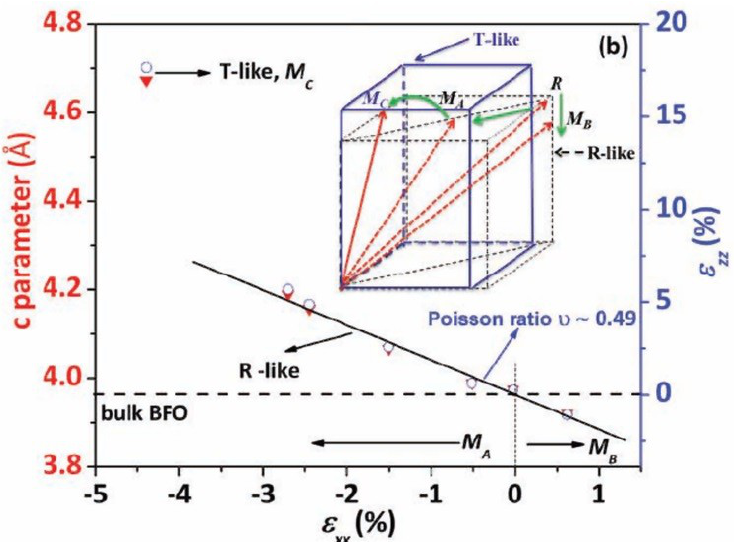
Figure 2. The out-of-plane lattice parameters (red) and ε lattice strain (blue) as a function zz of in-plane misfit strain ε . Inset is the possible strain-induced rotation path of polarization xx directions. (Reprinted with permission from [30]. Copyright 2011